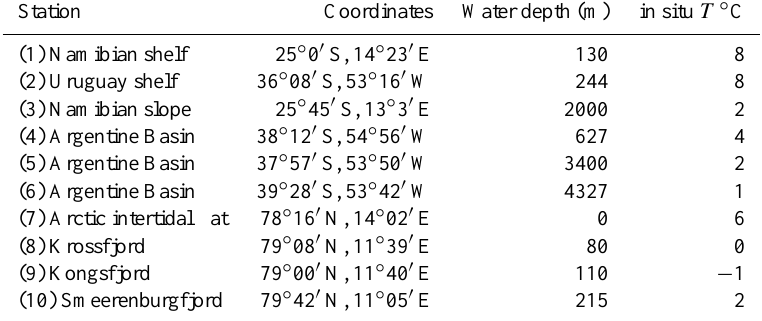
Table 1. Sampling sites